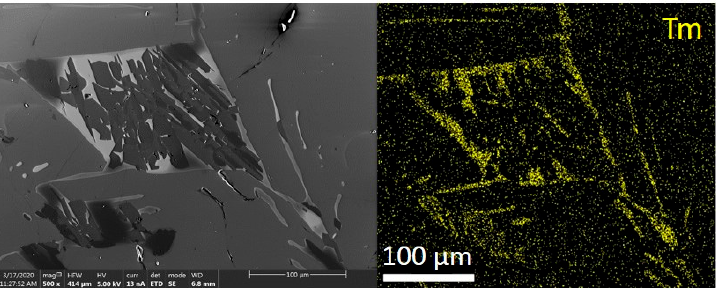
Figure 17. Sample presentation of the energy-dispersive spectroscopy analysis of the area from sample No. 18 of LMP doped with 1.2-mol% Tb and 10-mol% B, with mapping of the Tm distribu- tion (right-hand panel).